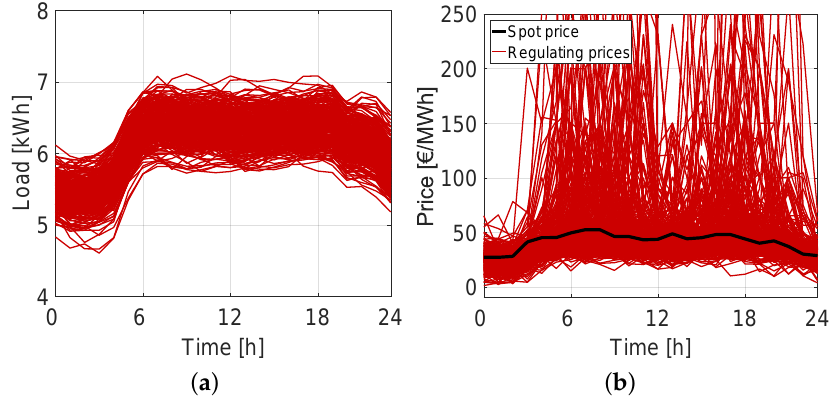
Figure 2. ( a ) Generated scenarios for the fixed load; and ( b ) Generated scenarios for regulating